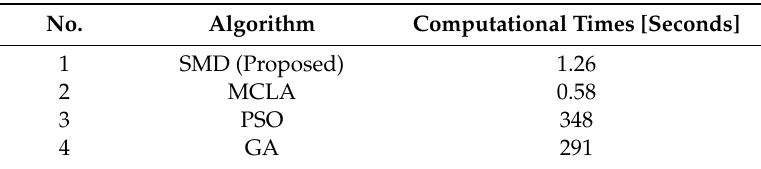
Figure12. Improvementofvoltagequalityatthefarthestpillar(P95),afterapplyingtheproposedalgorithm. Figure 12. Improvement of voltage quality at the farthest pillar (P95), after applying the proposed algorithm. Table 10. Comparison between the computational Table 8. The currents in the conductors of the first branch, SP-Pillar 8, the proposed algorithm.